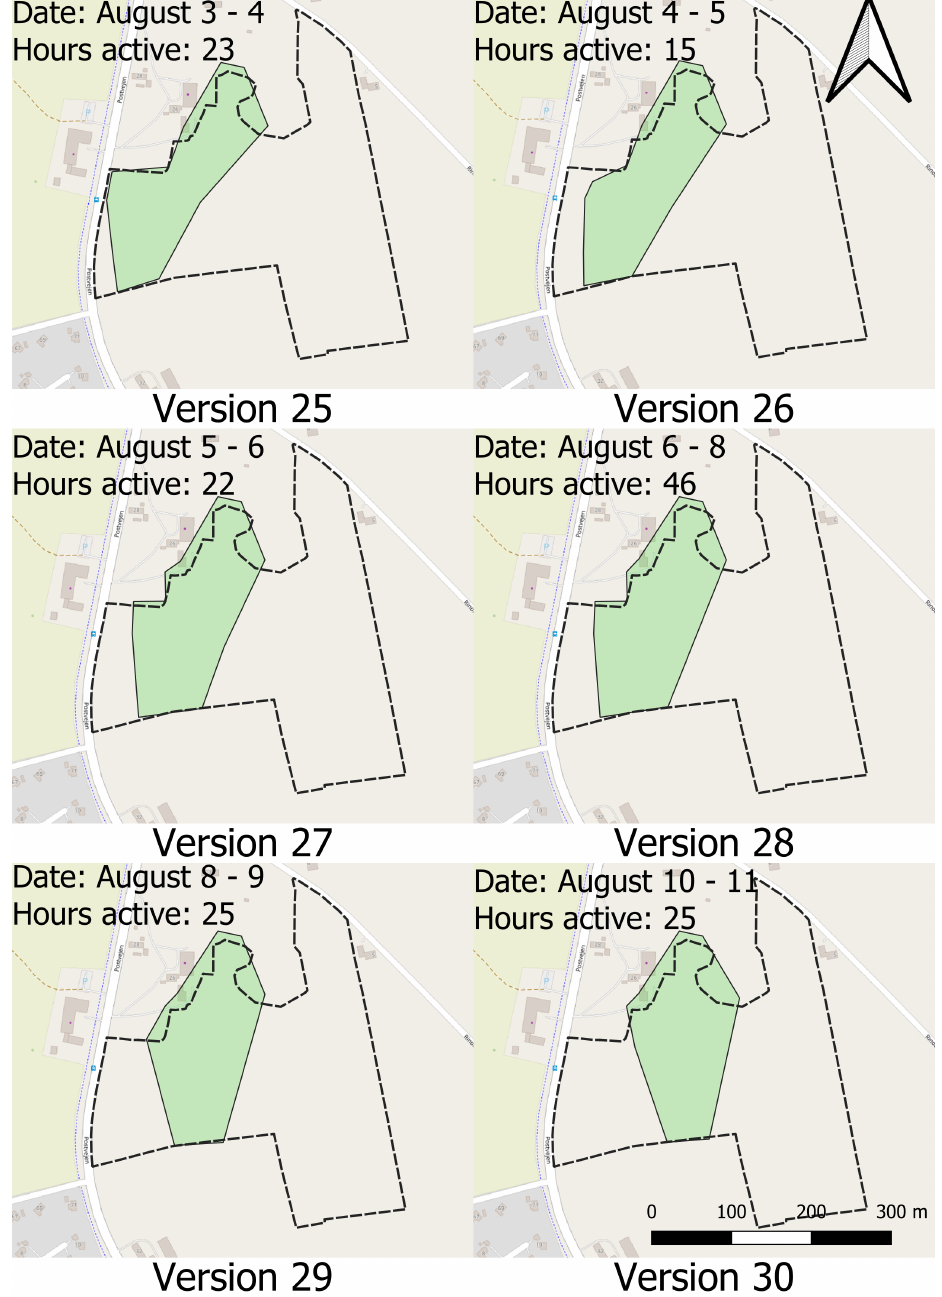
Figure A5. Virtual enclosure version 5 dating from 4 August to 11 August. The dashed black line represents the physical fence surrounding the 8.2 ha grazing area. The marked green area represents the virtual enclosure. Only virtual enclosures active for more than 12 h were included. The coordinates of the upper left corner of the map frame are 55°25 (cid:48) 23.131 (cid:48)(cid:48) E 8°23 (cid:48) 53.531 (cid:48)(cid:48) N. Map data from OpenStreetMaps